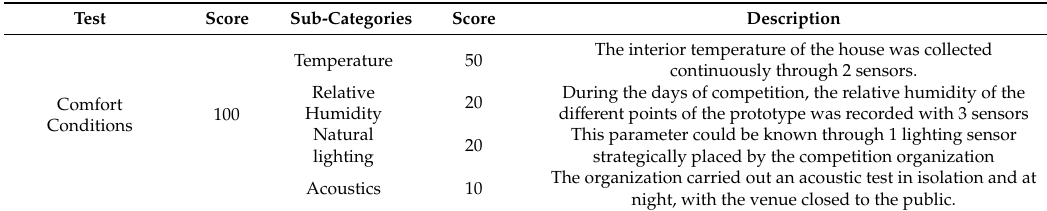
Table 3. Score of the “Comfort Conditions” test, taken from the competition